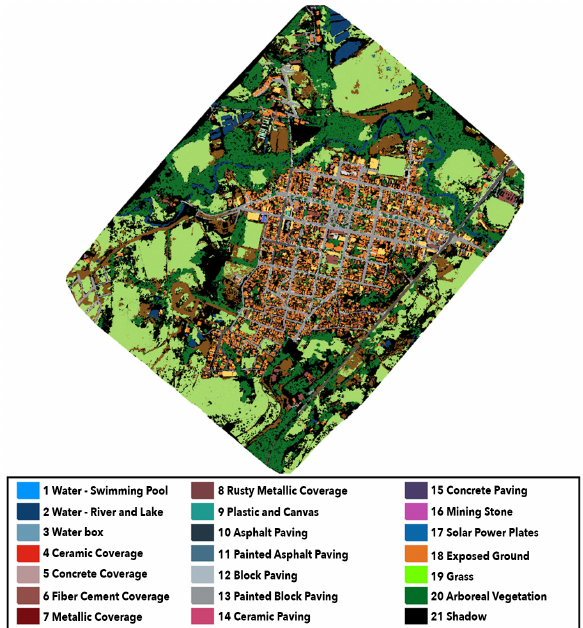
Figure 5. Ground-truth and classes A. Sample Collection. The classification performed in